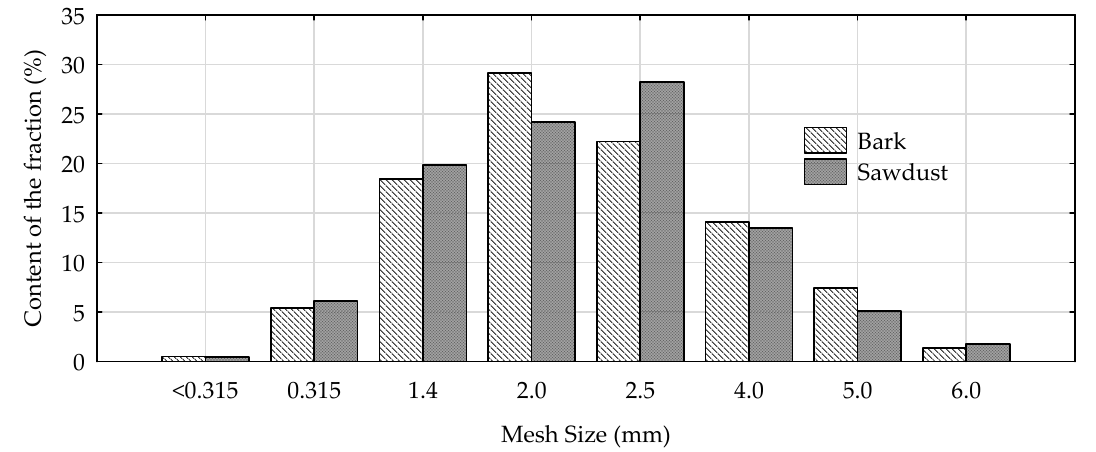
Figure 2. Fractional compositions of sawdust and bark.